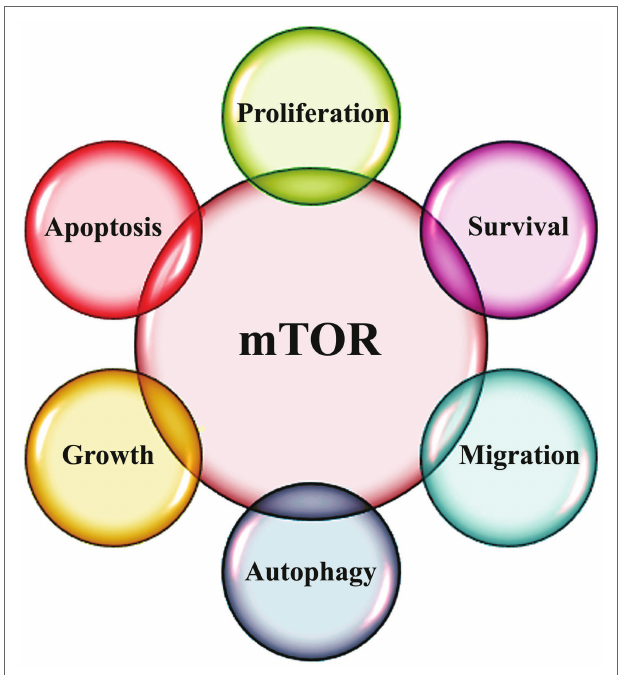
FIGURE 1 | Schematic diagram highlighting various functions of mTOR